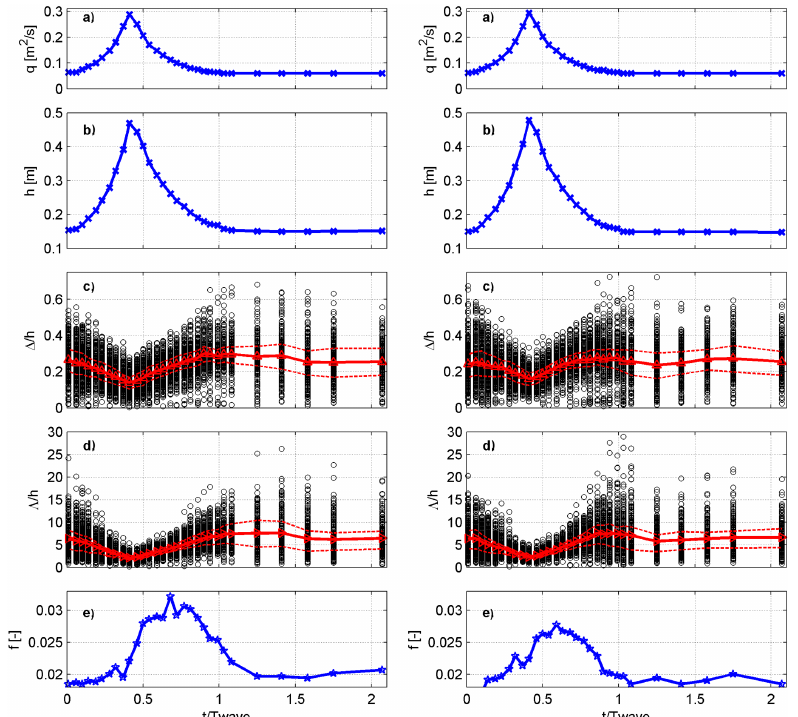
Figure 2. Timeseries of the T wave =3.5h T43 (left) and T wave =7h T44 (right) discharge waves of Wijbenga and Van Nes (1986a), with (a) specific discharge, (b) water depth, (c) normalized dune height of individual dunes (dots), average and 25 and 75% confidence intervals (red lines), (d) dune length and (e) total roughness, f .